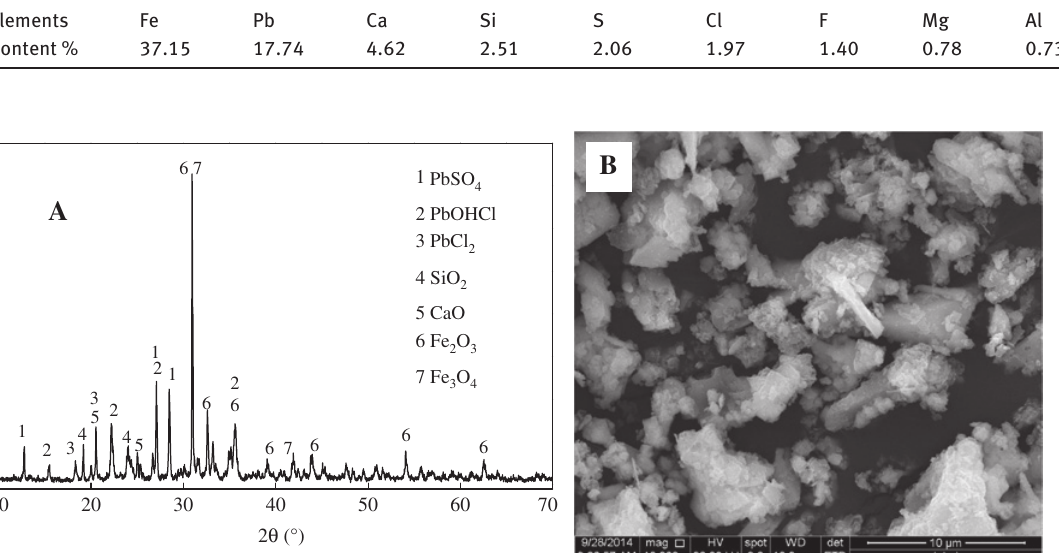
Table 1: Chemical composition of WLR-SD (mass fraction, %).